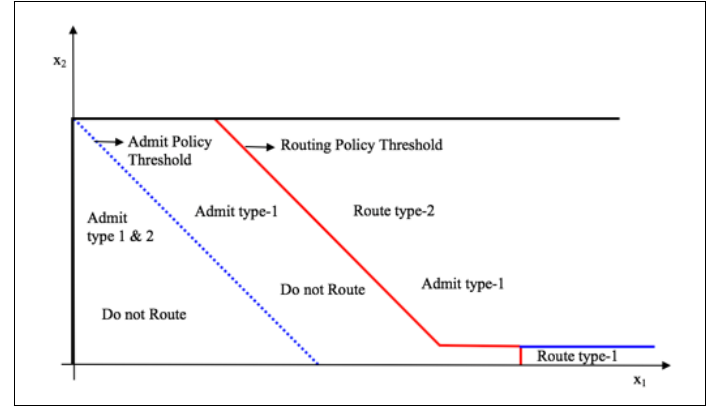
Figure 3. Admission and routing policy transient states for a given size of queue